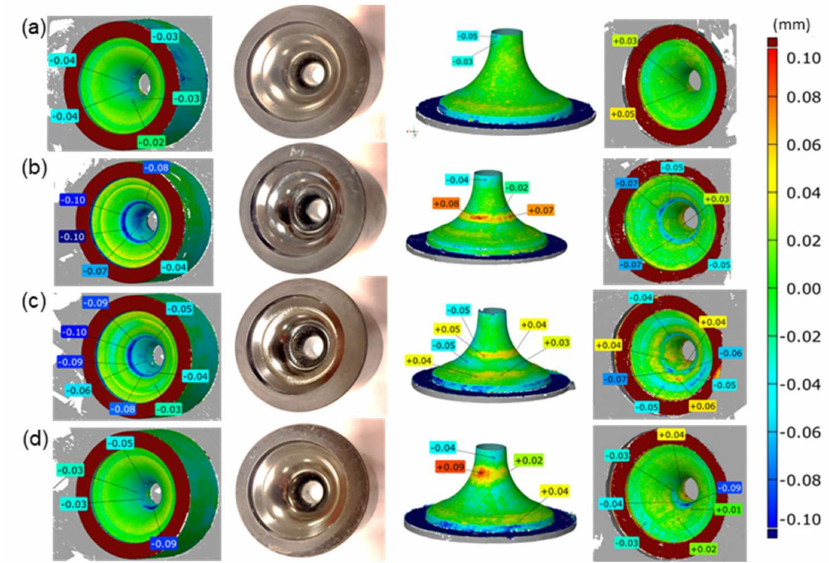
Figure 8. Compilation of the results of tool scanning, macro-photographs, 3D replica scans and a coloured mapof deviations for the dies obtained by way of reversing the 3D scan of the replica and comparing it to the nominal CAD scan (with standard setting of the angle, i.e., 55 ◦ for: ( a ) tools with an ALWIN coating after 1300 forgings, ( b ) with an ALWIN coating after 2400 forgings, ( c ) with a BIGAAN coating after 1090 forgings, ( d ) with a BIGAAN coating after 1900 forgings.